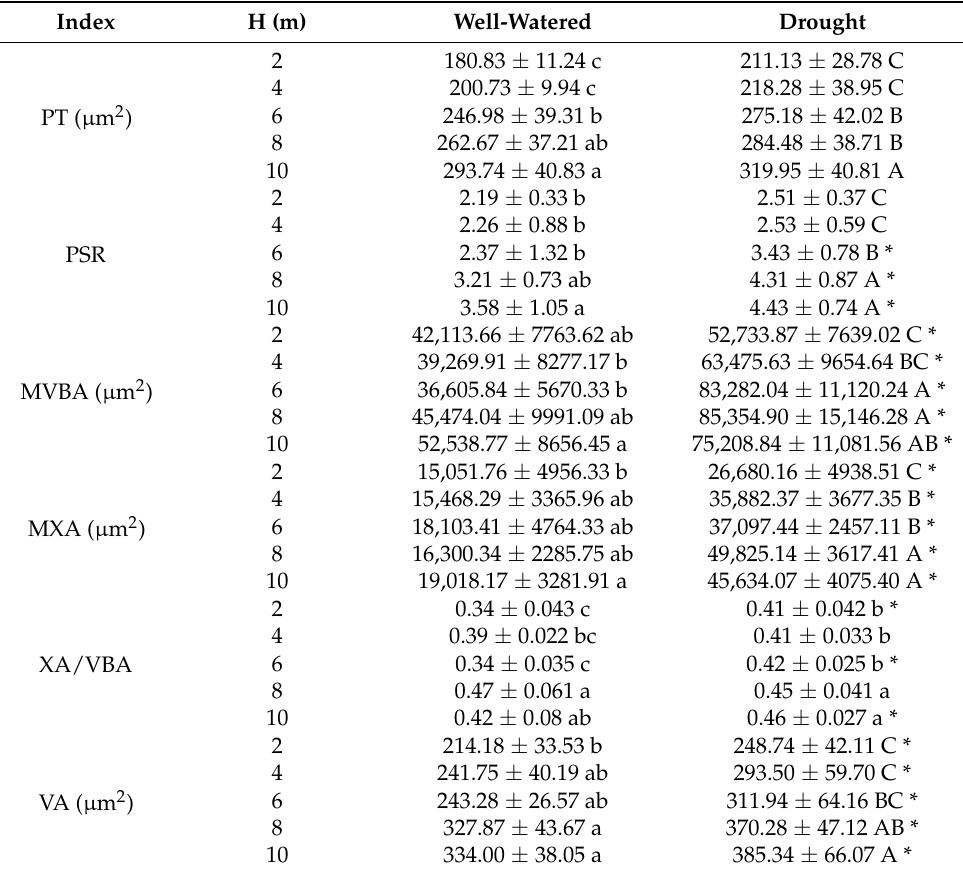
Table 1. Change in anatomical characteristics of the main veins of heteromorphic leaves with tree height under different soil moisture